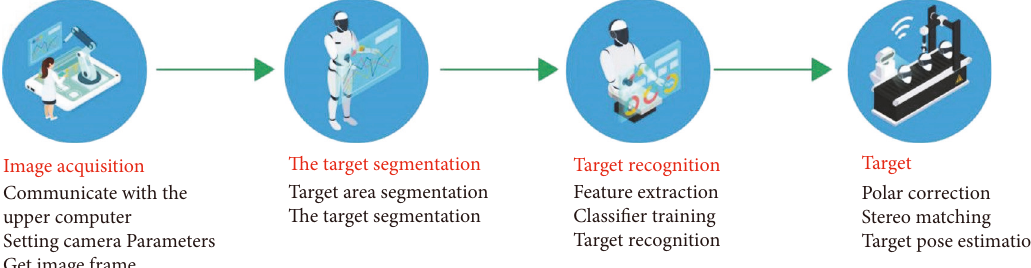
Figure 1: Software framework diagram of binocular system.